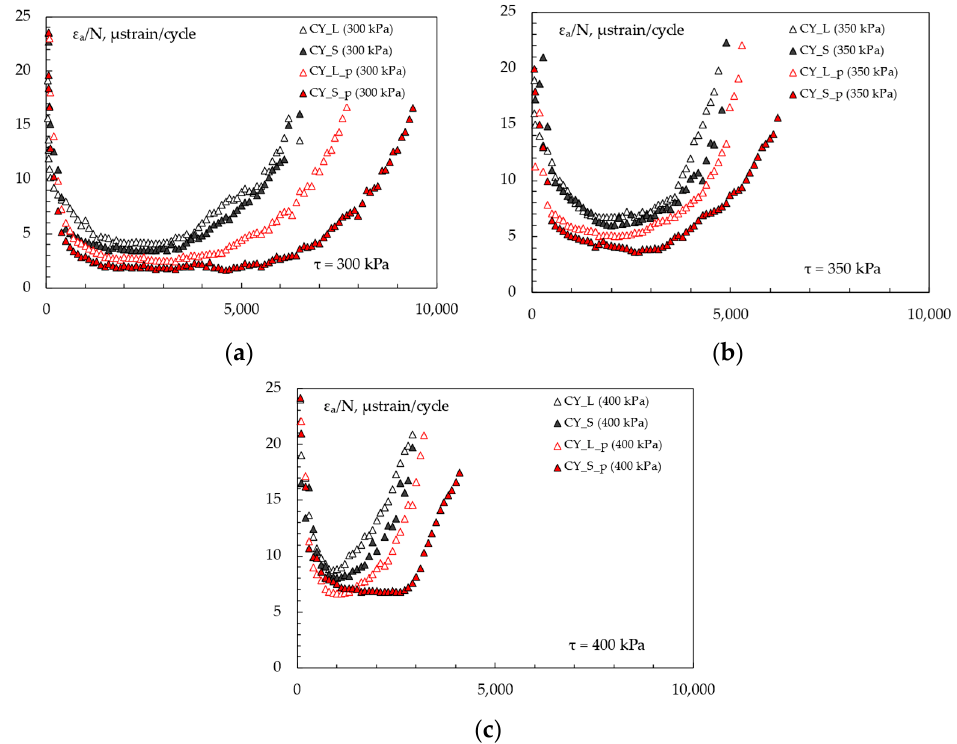
Figure 9. Rate of change in ε a vs. N for FN calculation: 300 ( a ), 350 ( b ), and 400 ( c ) kPa. Table 4. Numerical RLA test results (60 °C).